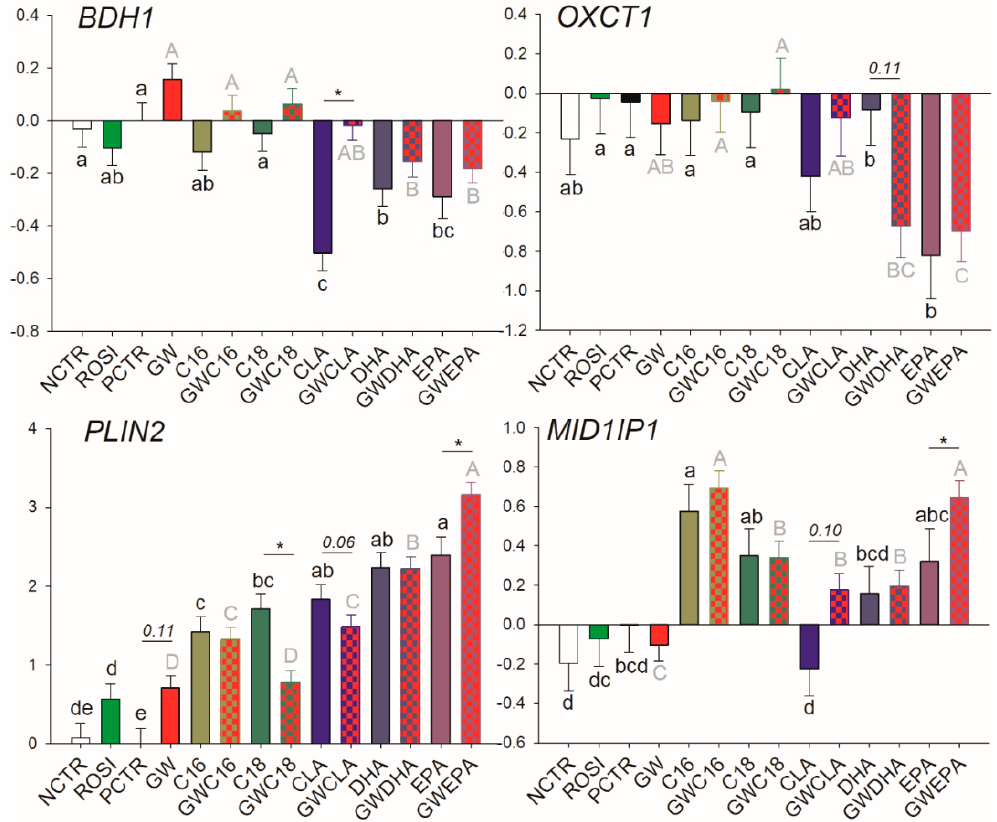
Figure 4. Effect of LCFA (palmitic acid [C16], stearic acid [C18], trans10, cis12 conjugated linoleic